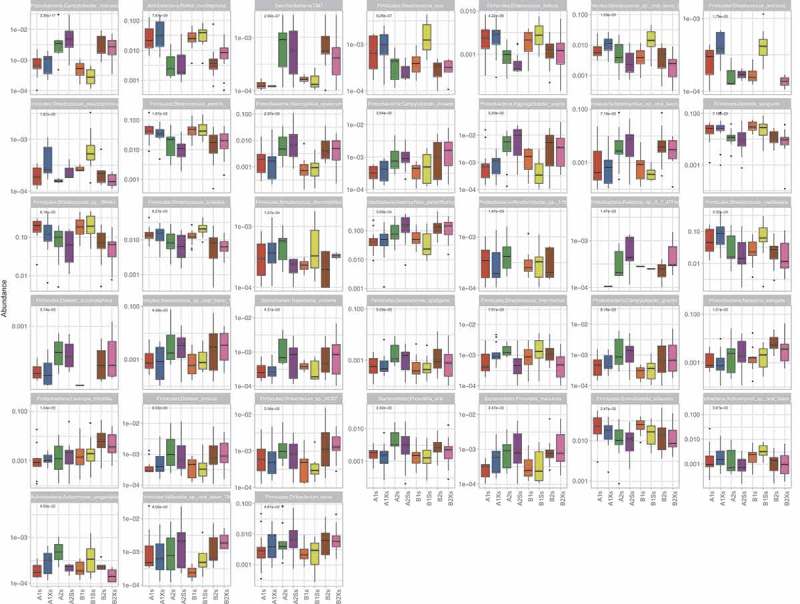
Species that showed significant differences in abundance (p < 0.05) among saliva samples collected from Group A and B at different time points.